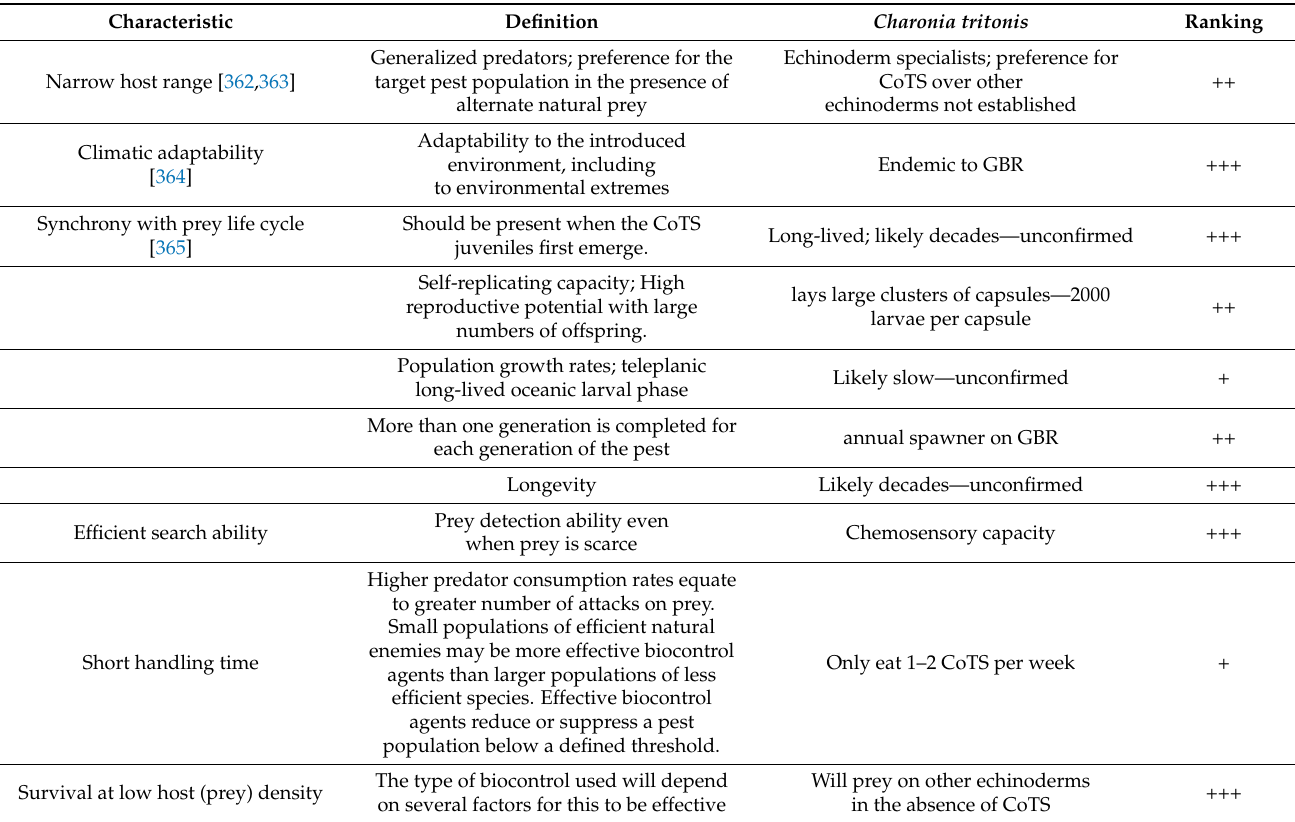
Table 7. Summary of characteristics of Charonia tritonis and amenability to Crown-of-Thorns Starfish (CoTS) biocontrol. Concept modified from [361]. Prey specificity, predation efficiency, lifespan, and secretion of the ‘landscape of fear’ feature as key attributes. Amenability is ranked as limited (+), likely (++) and certain